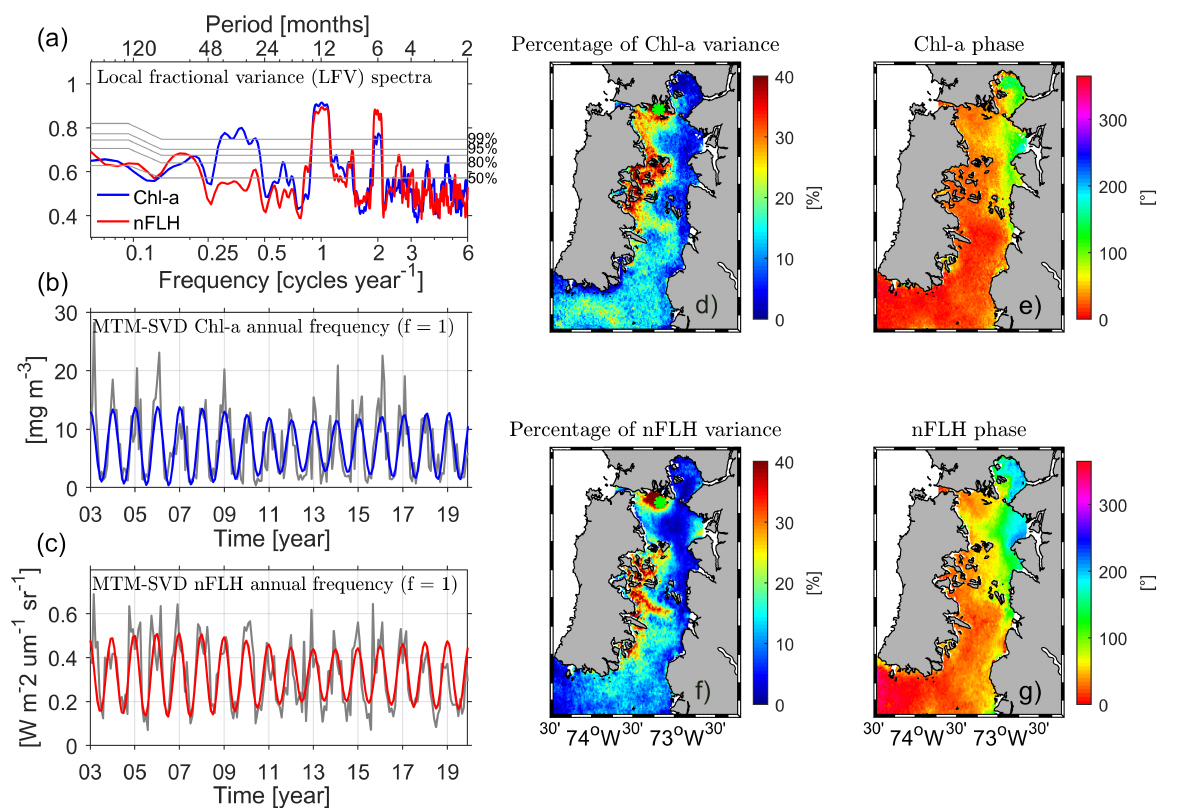
Figure 5. ( a ) Local fractional variance (LFV) spectra for Chl-a (blue curves) and nFLH (red curves). The values on the right hand side y-axis shows the confidence levels (%). Original time series (black lines) and reconstructed annual cycle (blue and red lines) for Chl-a and nFLH are shown in ( b , c ), respectively, for the location specified with a green asterisk in ( d , f ). The spatial field of explained annual variance and the corresponding phase is presented for Chl-a ( d , e ) and nFLH ( f , g ). For reference of locations, see Figure